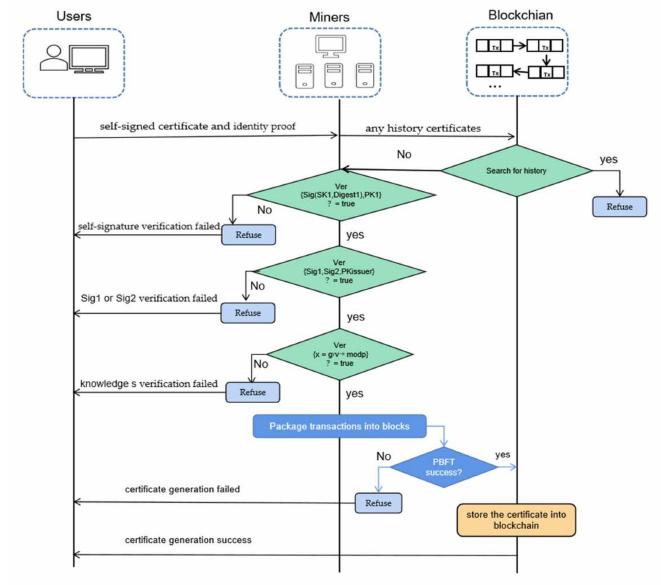
Figure 3. The verification process for certification generation.